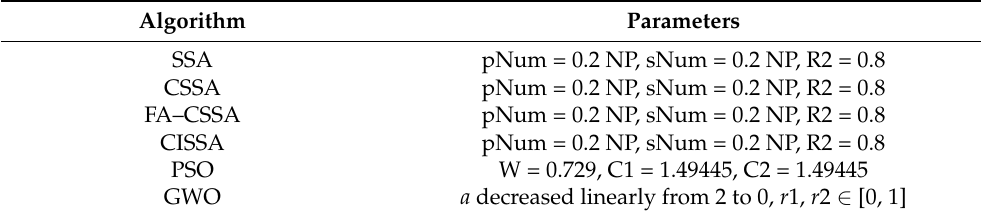
Table 3. Parameter setting for each algorithm.